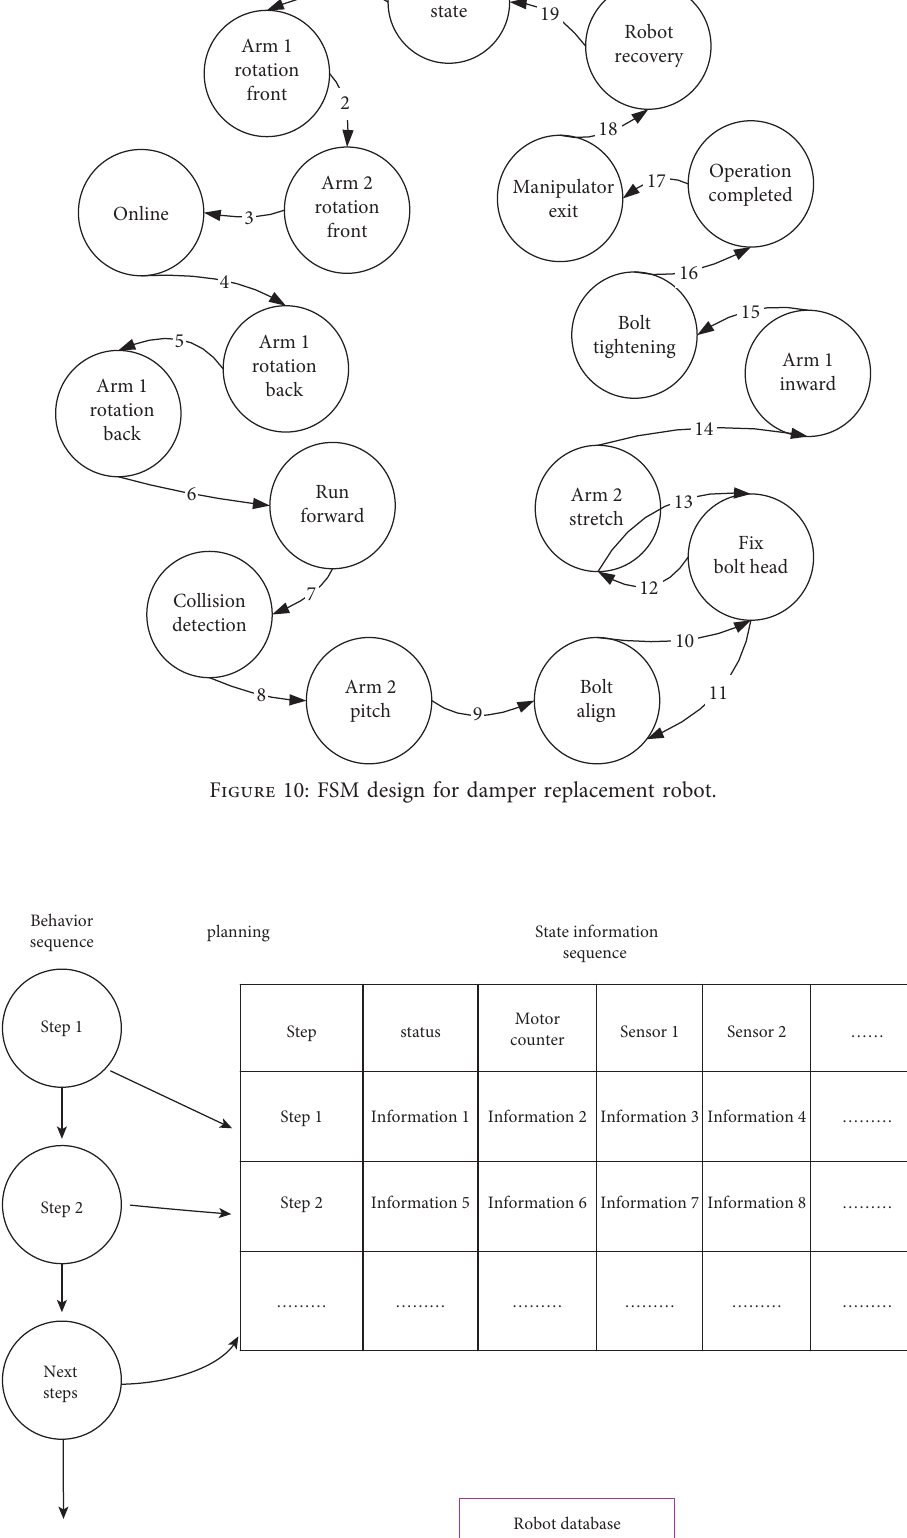
Figure 11: Robot status information sequence.